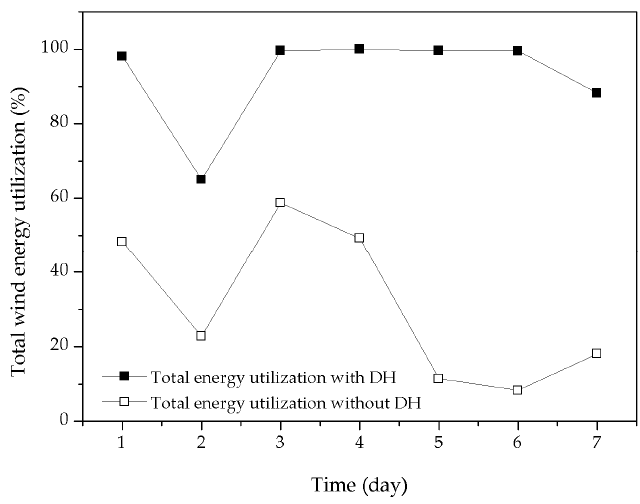
Figure 13. Daily evolutions of the total wind power utilization of WPP with and without DH. Table 3. Simulating results of the seven ‐ day operation performance.